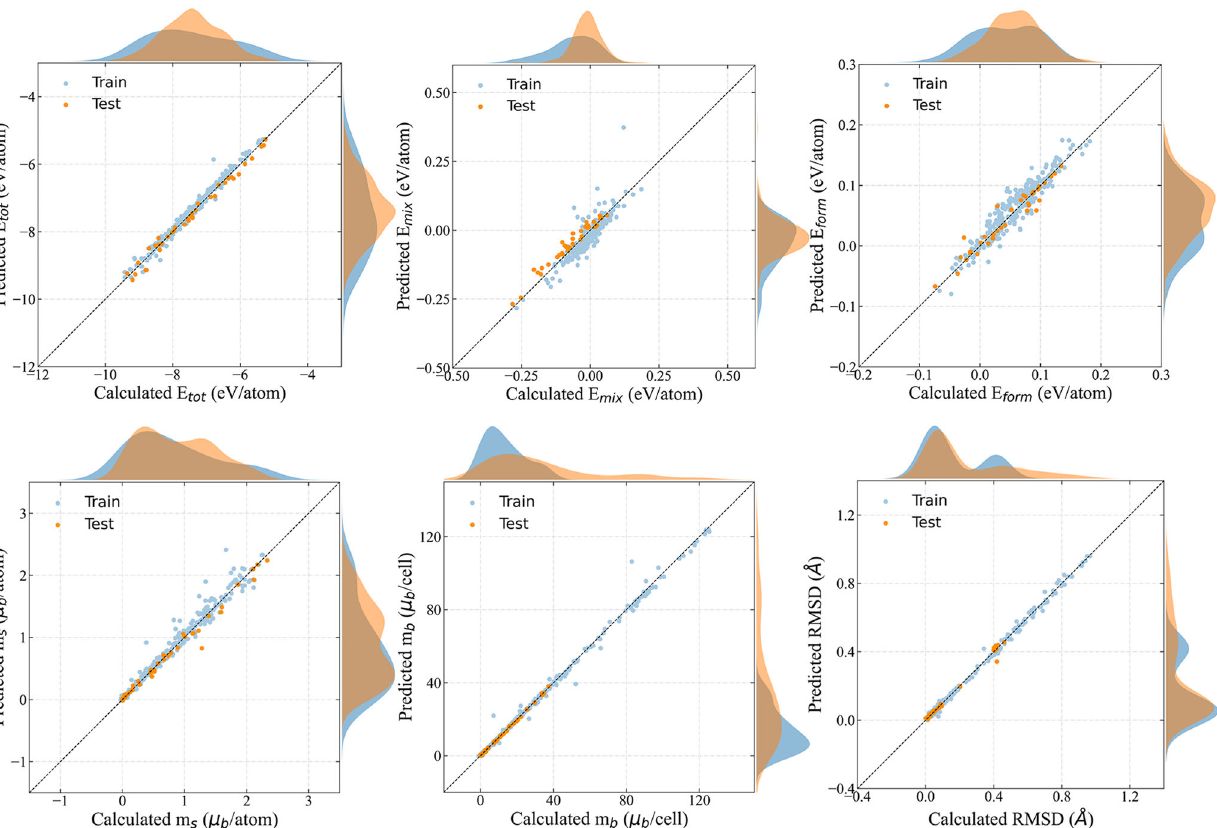
Fig. 4 Performance of ECNet models on properties of E tot , E mix , E form , m s , m b , and RMSD for CrFeNiCoMn/Pd alloy systems. The blue and orange circles are samples from training and test data sets, and their data distributions are displayed for reference.